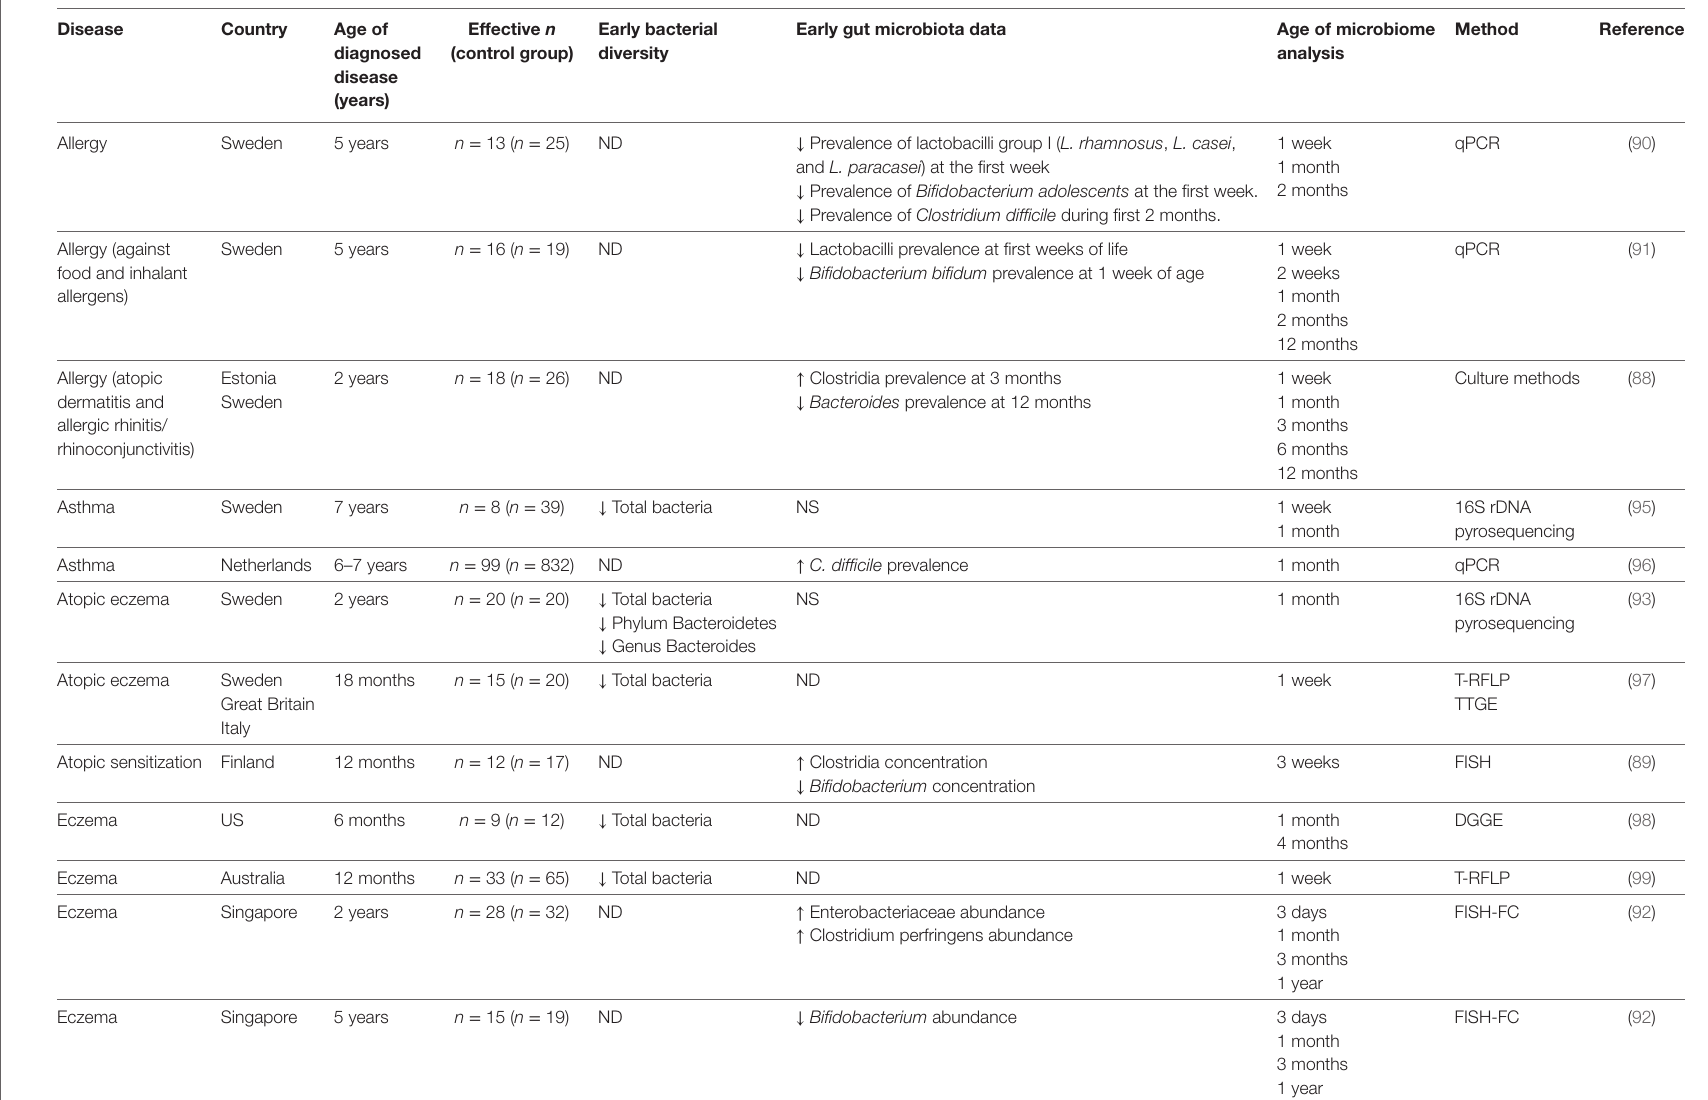
TAbLe 3 | Diseases associated with gut microbiota alterations in early life. Disease Country Age of